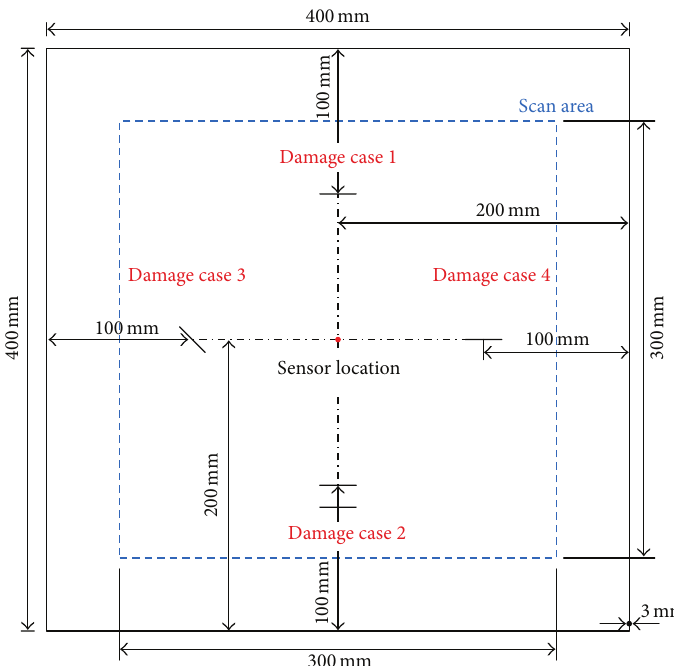
Figure 9: Damage cases: case 1: tangential to wave front, case 2: tangential to wave front (two damages), case 3: an angle of 45 degrees with wave front, and case 4: perpendicular to wave front; dotted line indicates the scan area.